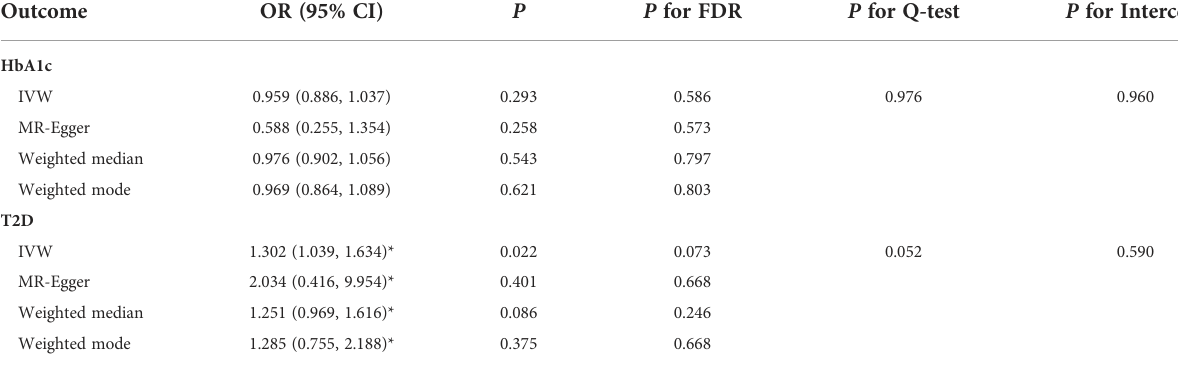
TABLE 2 Summary statistics for MR analyses of the potential causal effect of periodontitis on glycemic traits. Outcome P for